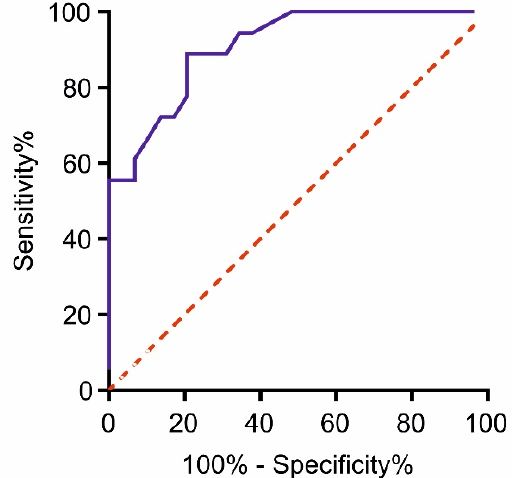
Figure 2. Receiver Operating Characteristics (ROC) curve obtained by comparing ERBB2 CNV values of the HER2 positive patients vs. CNV values of the HER2 negative ones. HER2 positive or negative status was determined using IHC/SISH staining as “standard method”. Area under the curve (AUC) 0.909, Std. Error 0.04091, CI 95% 0.8288–0.9892, p -value < 0.0001.